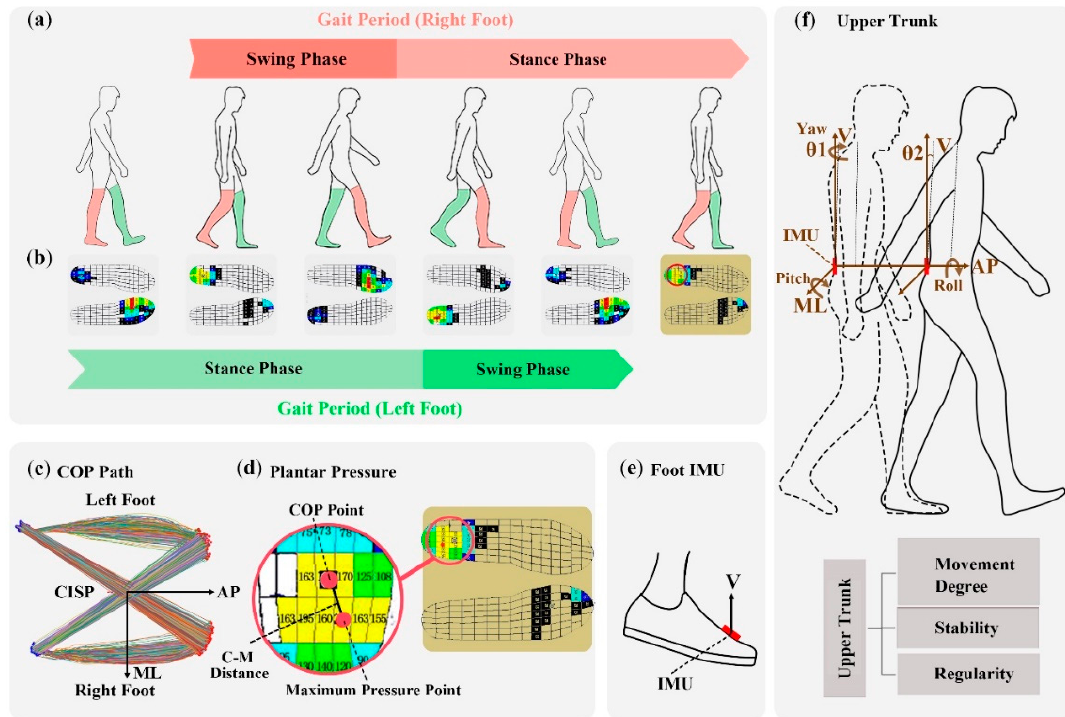
Figure 2. ( a ) A diagram of entire gait period for left and right foot, including swing phase and stance phase. ( b ) The Plantar pressure during entire gait period for analyzing gait features of stance phase. ( c ) Representation of center of pressure (COP) path cyclogram. CISP, ML, V and AP respectively denote cyclogram intersection point, mediolateral, vertical and anterior-posterior. During stance phase, COP position moves forward under support foot. When support foot becomes the other foot, COP position moves from one foot to the other. ( d ) The position of COP point, the position of maximum pressure point and C-M distance means the average distance between these two points. ( e ) IMU is attached to foot for analyzing gait features of swing phase. ( f ) A diagram of upper trunk movement degree, stability and regularity when walking. θ means upper trunk movement degree in pitch direction.